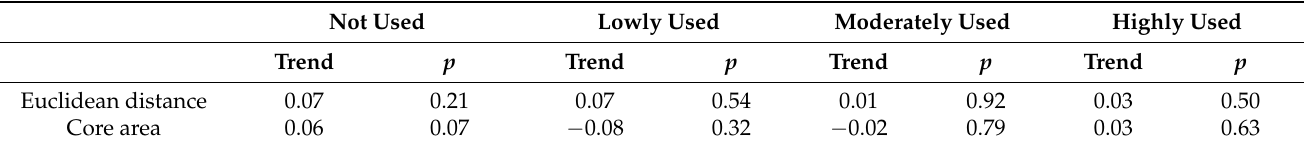
Table A3. Results of the trend analysis for the change in the mean Euclidean distance between grazing patches (m), and of the percentage of the landscape that is grassland core area (%) column indicates the slope calculated with the Theil-Sen method (annual change for the variable of interest). p indicates the degree of significance according to the Mann-Kendall test. Not Used Lowly